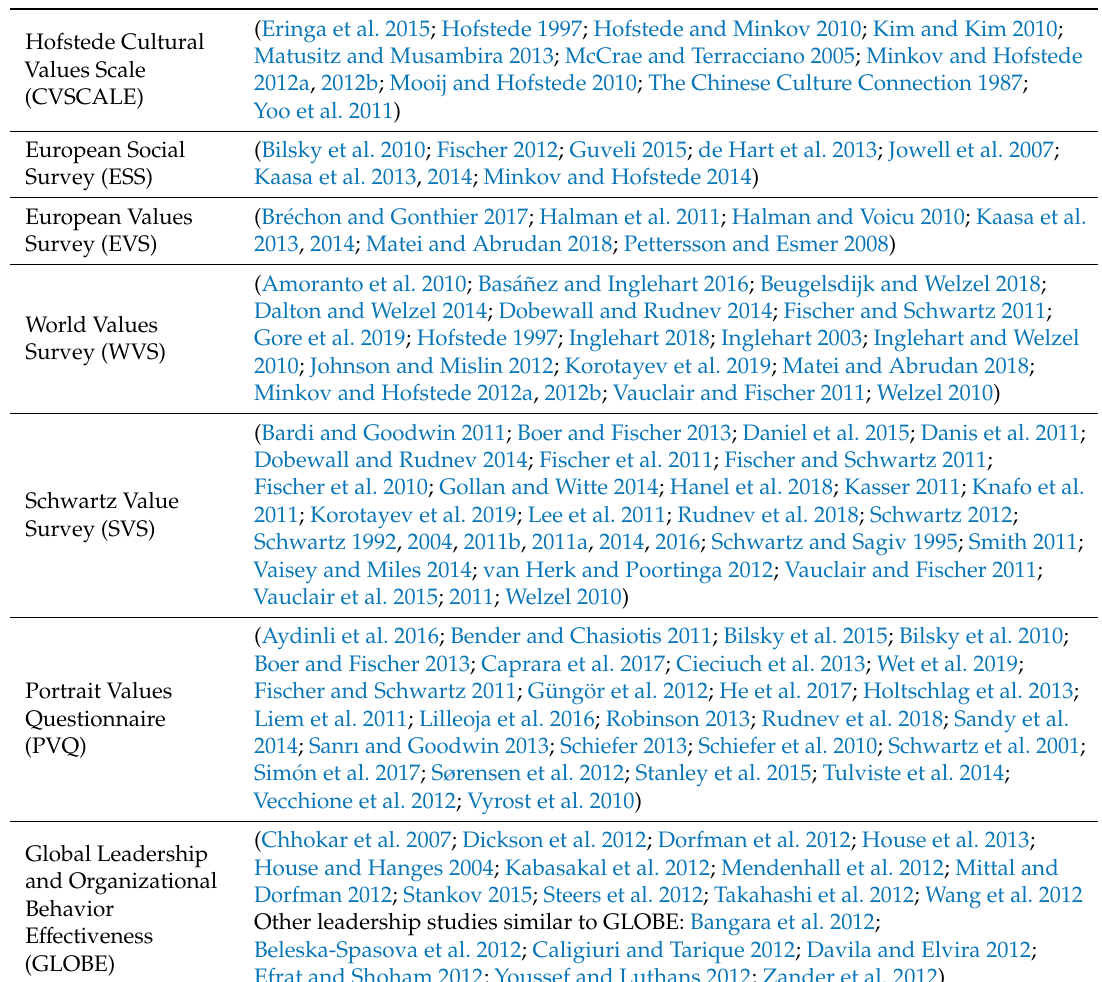
Table 1. Reviewed Cross-Cultural Surveys and